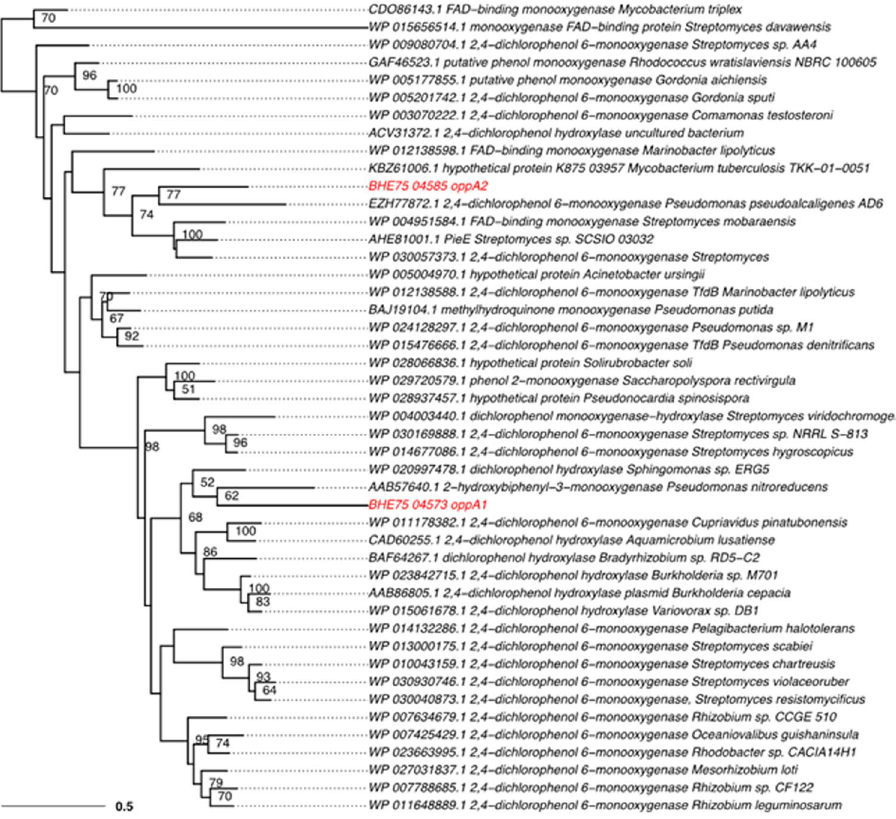
Figure 6. Maximum likelihood tree of the two flavin-dependent monoxygenases OppA1 and OppA2 found in the genome of the S. haloaromaticamans using 1000 bootstrap replicates and the Le-Gascuel (LG 67 ) model with gamma rate heterogeneity and accounting for invariable